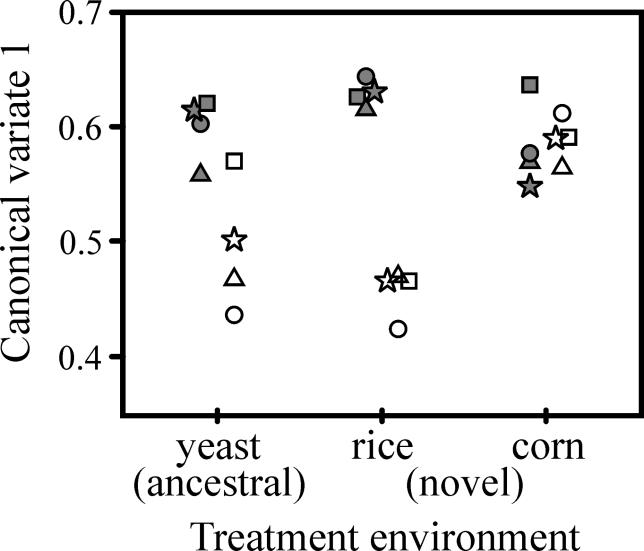
Adaptation of Male and Female CHCs to the Different Treatment EnvironmentsVariation among populations is presented as the first CV of the sex × treatment interaction from a MANOVA of the eight logcontrast CHCs of individuals from the 12 populations. Males are represented by filled symbols, and females by open symbols. The four replicate populations within each treatment are indicated by the different shaped symbols (there is no correspondence among treatment environments of populations represented by the same symbol).